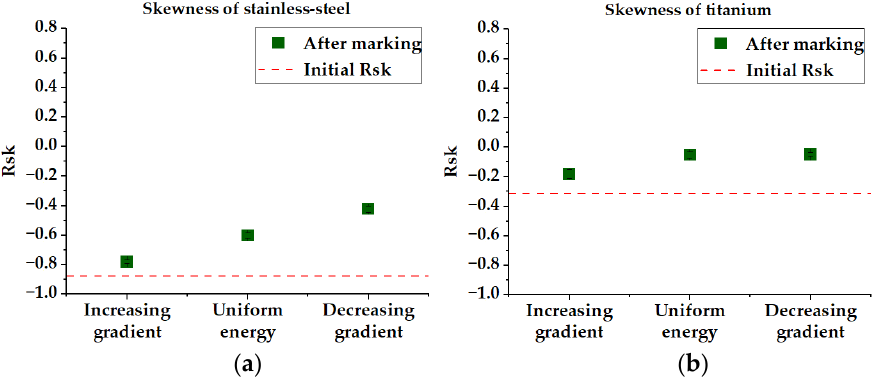
Figure 7. 𝑅 (cid:3046)(cid:3038) parameters of ( a ) stainless steel and ( b ) titanium. The 𝑅 (cid:3046)(cid:3038) = 0 corresponds to a sym- Figure 7. R sk parameters of ( a ) stainless steel and ( b ) titanium. The R sk = 0 corresponds to a metrical profile. symmetrical